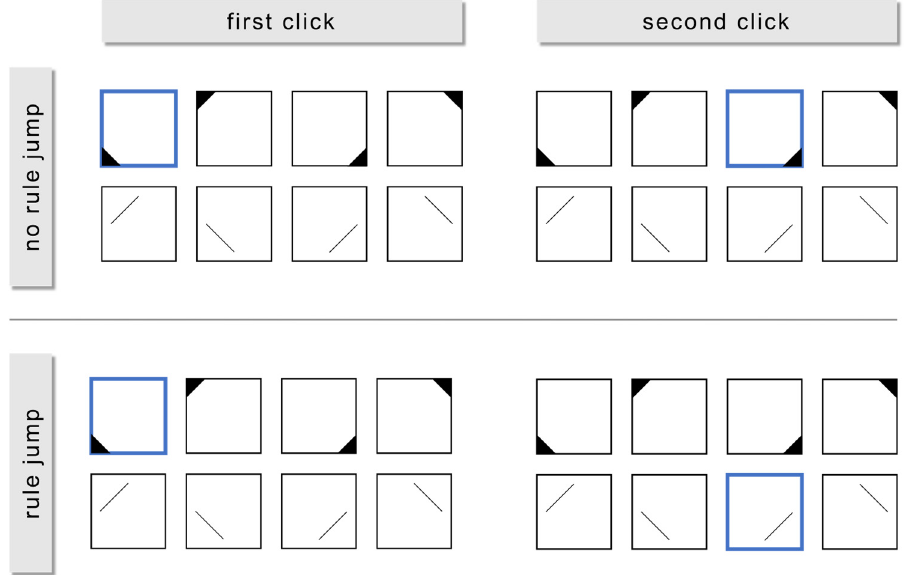
Figure 2. The upper section of the figure shows an example of a click (framed in blue) sequence without any rule jump, since the second click selects a symbol of the same symbol group as the first click. By contrast, the lower section shows an example of a click sequence with a rule jump, since the second click selects a symbol of a different symbol group than the first click.